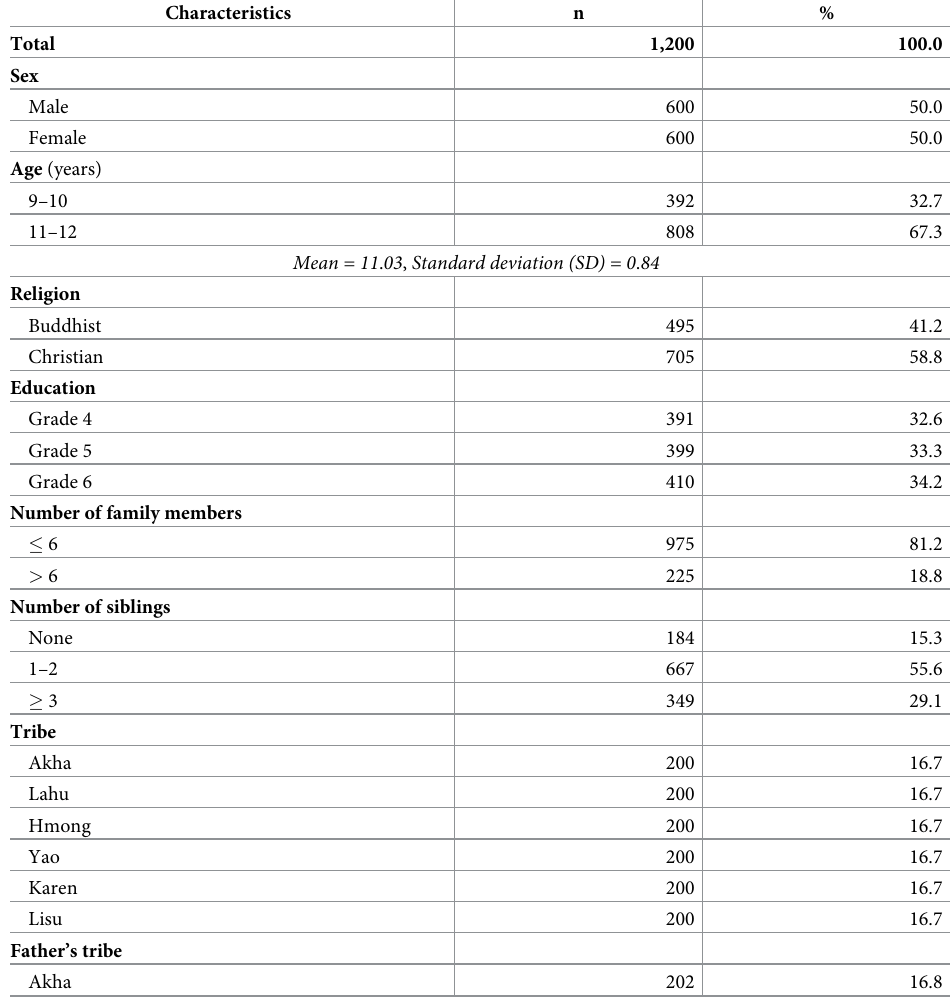
Table 1. General characteristics of the